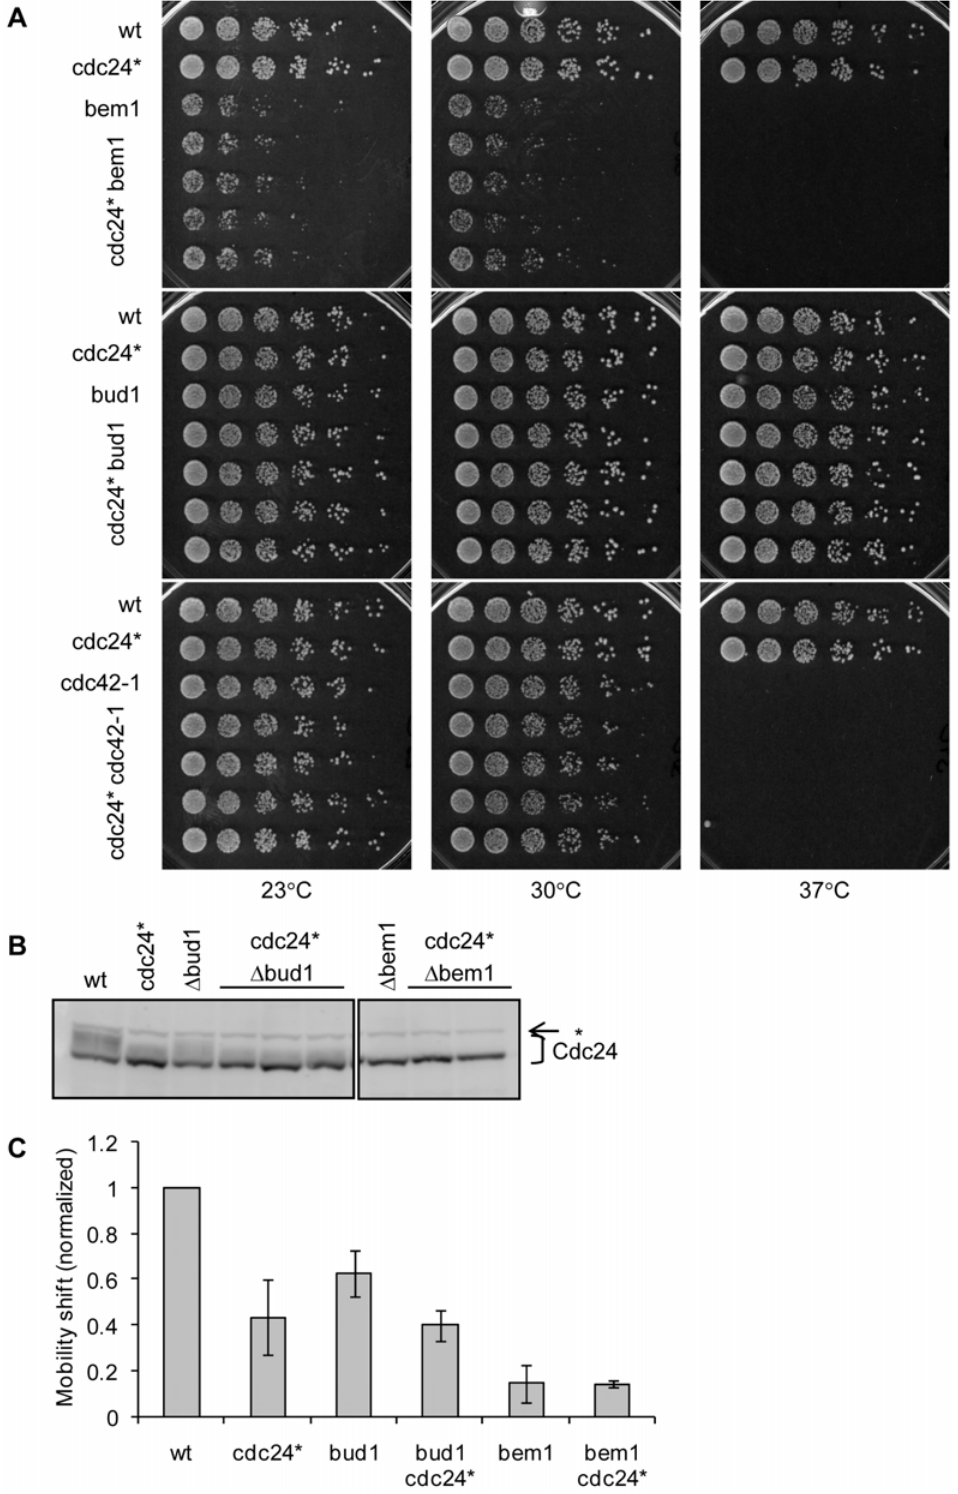
Figure 4. No synthetic effects on cell growth or mobility of Cdc24 are detected between CDK-A/PAK-A mutant and other polarity mutants. The cdc24 CDK-A/PAK-A strain is labeled here as cdc24* for simplicity. A. Serial dilutions of meiotic segregants from crosses between cdc24* (RLY2937) and polarity mutants D bem1 (RLY2771), D bud1 (RLY2773), and cdc42-1 (RLY171). Double mutant strains were spotted onto YEPD agar plates and grown for 3 d at 23 u C, 30 u C, 35 u C (not shown), and 37 u C. B. Mobility shift of Cdc24 band. Whole cell extracts were prepared from asynchronous cultures of meiotic segregants from crosses between cdc24* (RLY2937) and D bem1 (RLY2771) and D bud1 (RLY2773). Blots were probed with rabbit anti-Cdc24 antiserum. Faint band just above smear is a cross-reacting protein (*). C. Quantification of mobility shift, calculated, normalized, and displayed as in Figure 2B.